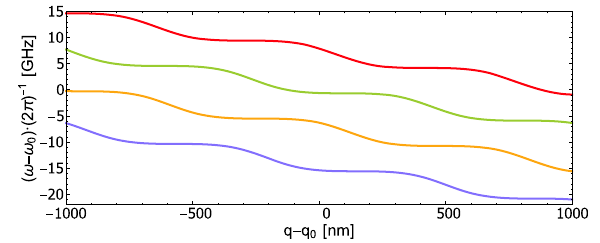
Fig. 5 Optical resonance for bulk acoustic wave (BAW) resonator inside Fabry – Perot cavity. The cavity optical frequency ω and thickness q of the BAW resonator are plotted using the shift from their respective initial values ω 0 and q 0 . The curves represent four selected optical modes, which are separated by the sinusoidally varying free spectral range of the cavity.